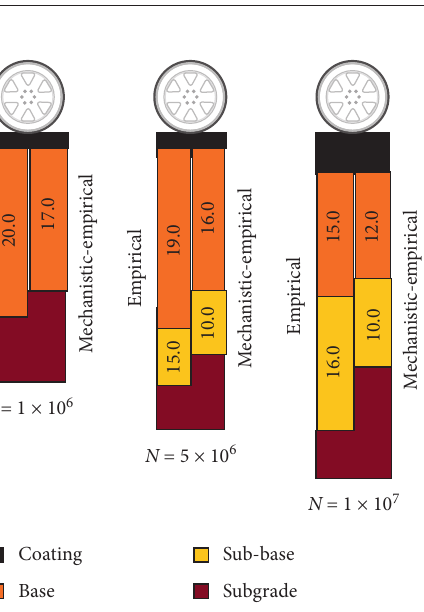
Figure 6: Thickness of the layers (cm) of the paving. Figure 7: Distribution of vertical strains on the